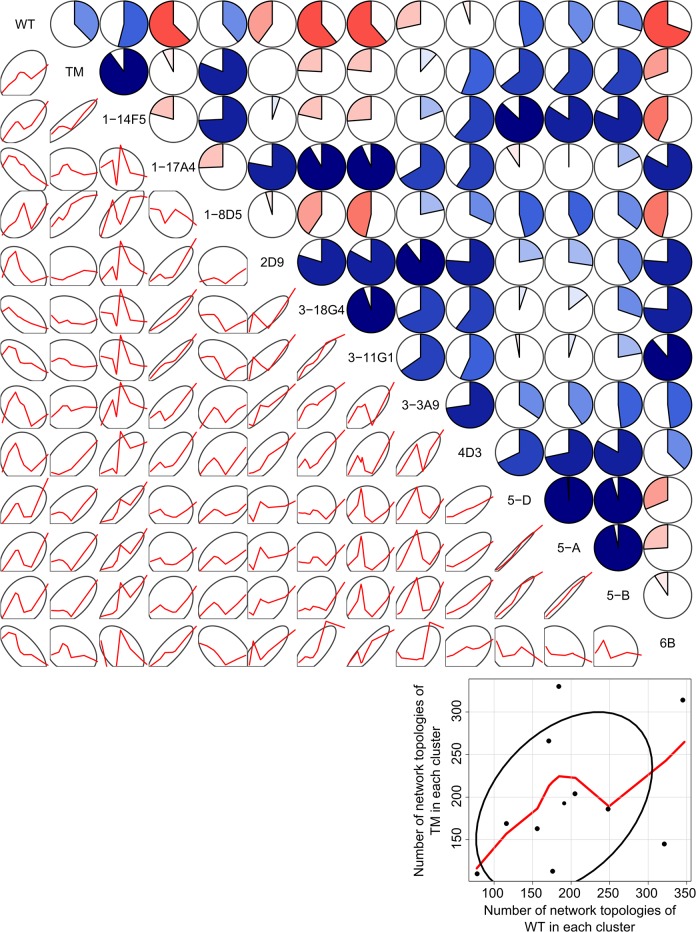
Pairwise correlations of cluster distributions (using 10 clusters) of unfolding pathways of wild type BsLipA and mutants from Rao et al.The upper triangle shows pairwise correlation coefficients as dial plots where a filled portion of a pie indicates the magnitude of the correlation (r) and blue (red) color indicates a positive (negative) correlation. The lower triangle shows 68% data ellipses (depicting the bivariate mean ± 1 standard deviation) [90] and scatterplots of the respective cluster distributions (frequencies of network topologies in each of the 10 clusters) of the two BsLipA variants as red lines smoothed by locally-weighted polynomial regression [91]. Data points and axes for the plots in the lower triangle are omitted for clarity. The blow-up in the right bottom corner depicts exemplarily for the TM versus WT case axes, axes labels, data points, the smoothing line obtained by locally-weighted polynomial regression, and the 68% data ellipsis. The figure was generated using the “corrgram” package [92] of the R program (http://www.r-project.org).